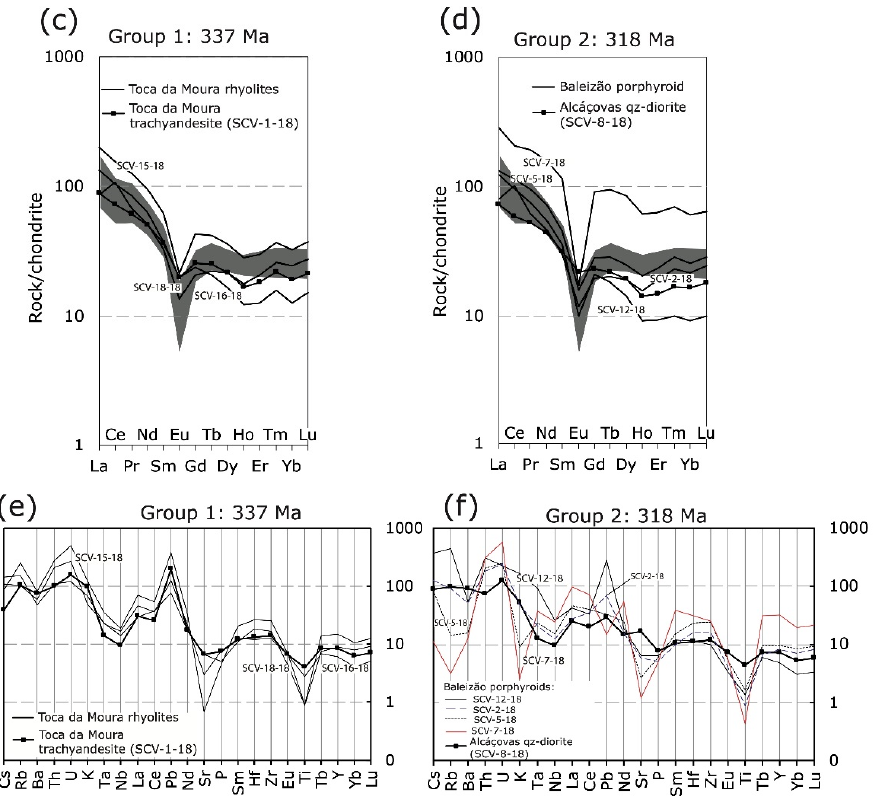
Figure 5. ( a ) Y vs. Nb diagram [52] discriminating between volcanic arc granite and syncollisional granites (VAG+SynCOLG), within plate granites (WPG) and orogenic granites (ORG). Data of the Baleiz ã o porphyries ([20]; grey dots) and the Toca da Moura mafic-intermediate volcanic rocks ([50]; light blue squares) are used for comparison. ( b ) Ta/Yb vs. Th/Yb diagram [51] shows the geochemical affinity with active continental margin magmatism. Data of Baleiz ã o porphyries from Alvito, Torr ã o and Alc á çovas regions [20] are used for comparison (grey dots). ( c , d ) Chondrite normalized rare earth element (REE) diagrams showing the main REE patterns of the Toca da Moura (Group 1) and the Baleiz ã o-Alc á çovas (Group 2) igneous rocks. Data of Baleiz ã o porphyries from Alvito, Torr ã o and Alc á çovas regions [20] are used for comparison (grey zone). ( e , f ) Primitive mantle-normalized trace elemental patterns of Group 1 and 2 igneous rocks.